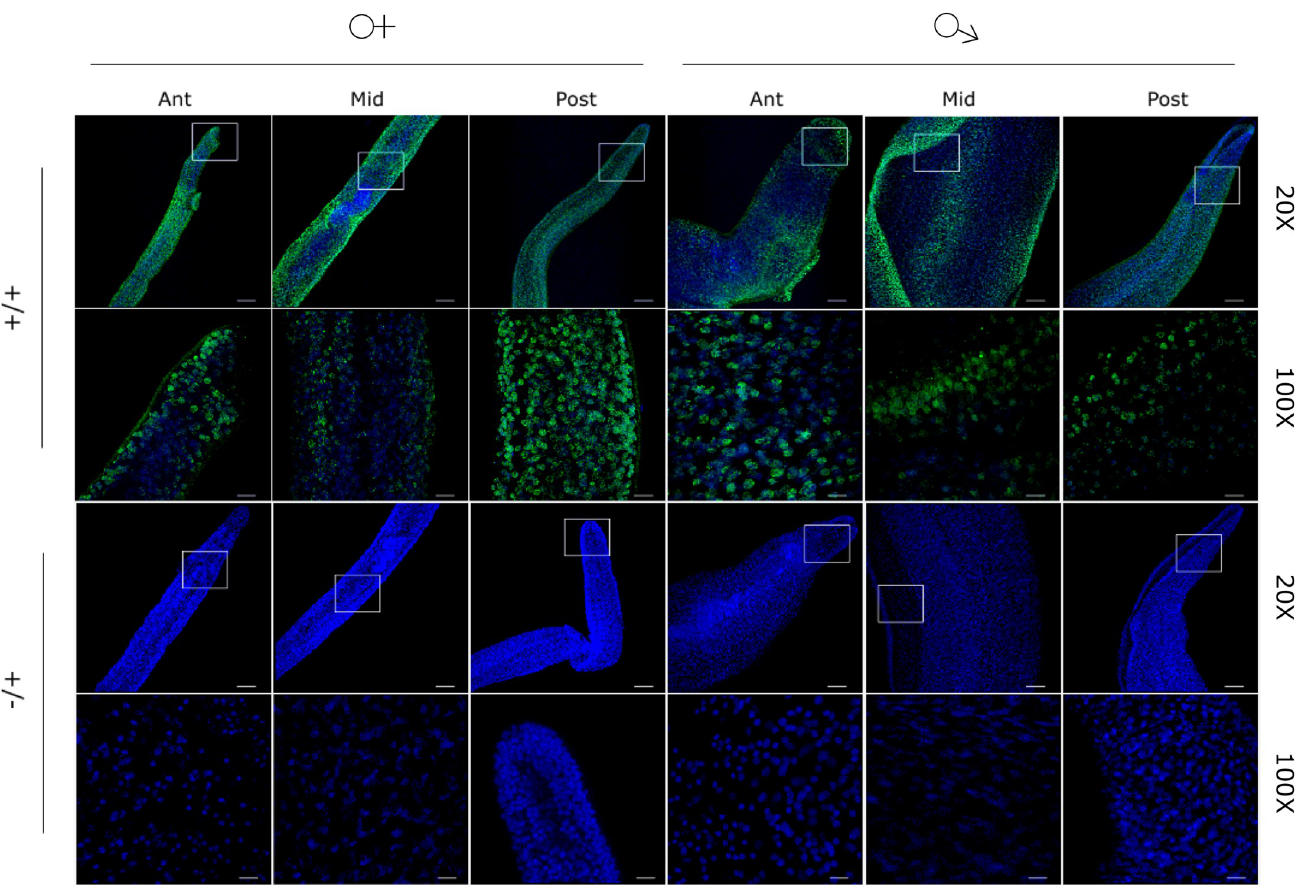
Fig 6. G4 structures are detectable in adult schistosomes. Male and female worms were stained with anti-quadruplex recognising BG4 (green) and counterstained with DAPI (blue). +/+ denotes the use of both primary and secondary antibodies, -/+ denotes the use of secondary antibody only (control). Z stacks of adult anterior (Ant), midsection (Mid) and posterior (Post) regions were taken using a Leica SP8 confocal microscope. Samples were imaged at 20X (scale bar = 50 μ m) and then 100X, (scale bar = 10 μ m), with box denoting region enlarged. Strong BG4 signal (488 nm) is co-localised with DAPI signal (405 nm) and is observed in both female and male